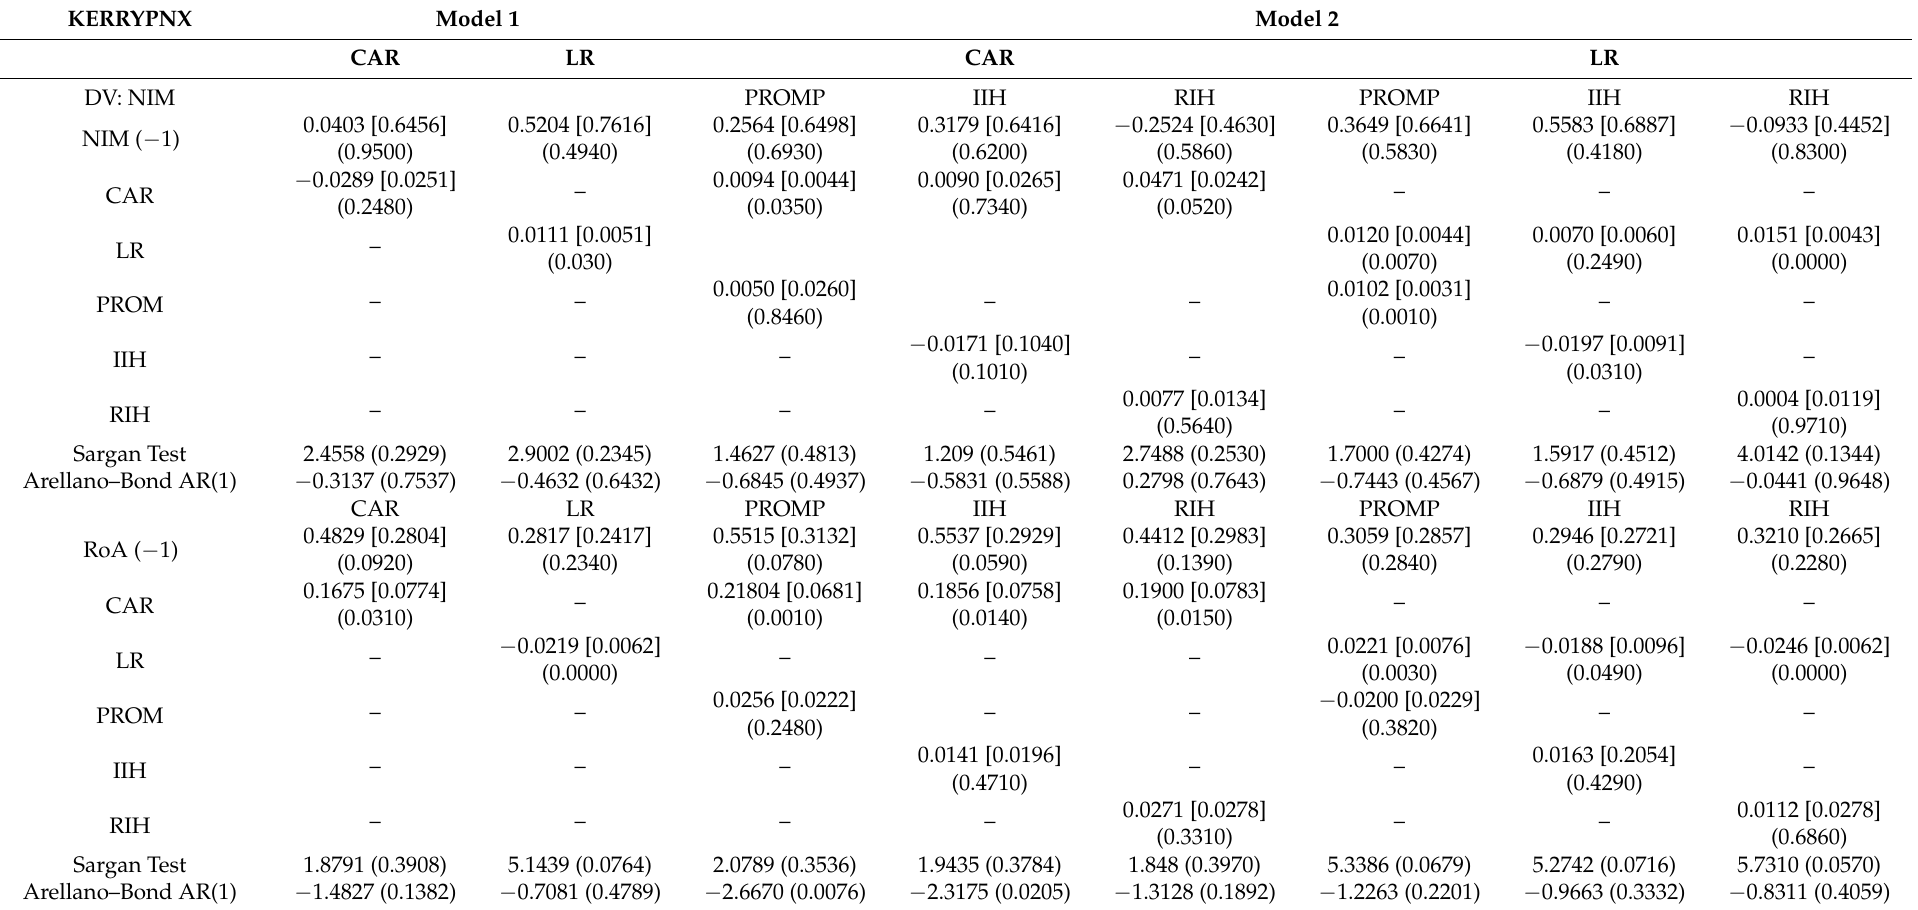
Table 4. Regression results: profitability (NIM/ROA) as the dependent variable on